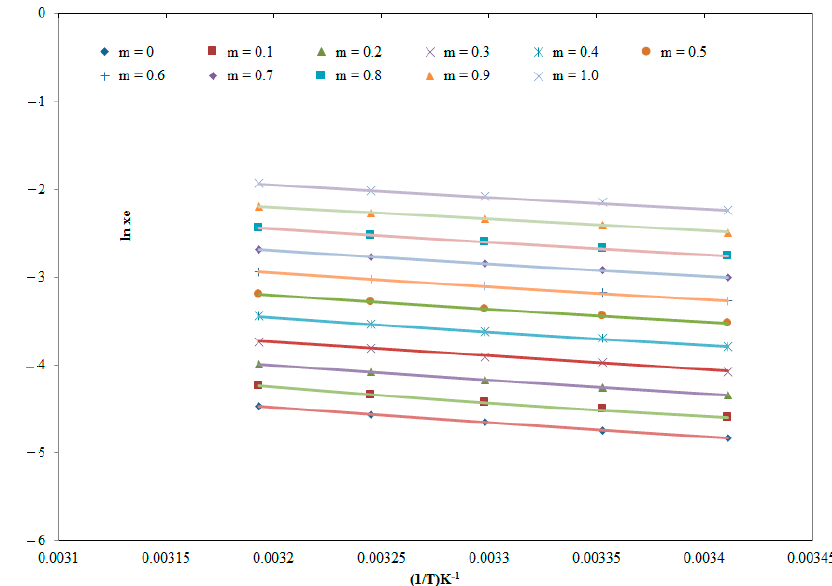
Figure 5. Graphical correlation of logarithmic solubilities of ECT with the “Apelblat model” in various “PEG-400 + water” combinations at “ T = 298.2 to 318.2 K” (solid lines indicate the “Apelblat solubilities” of ECT and symbols indicate the experimental solubilities of ECT). Table 7. Log x Yal values of ECT obtained by the “Yalkowsky-Roseman” model in various “PEG-400 + water” combinations ( m ) at “ T = 298.2 to 318.2 K”.